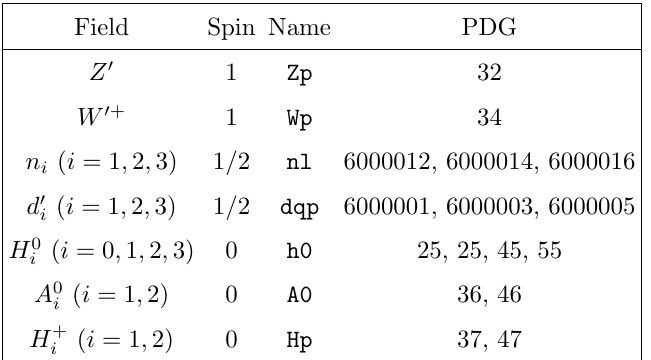
Table 7 . Mass eigenstates that supplement the SM, together with their spin quantum number (sec- ond column), the name used in the FeynRules implementation (third column) and the associated PDG identi(cid:12)er (last column).